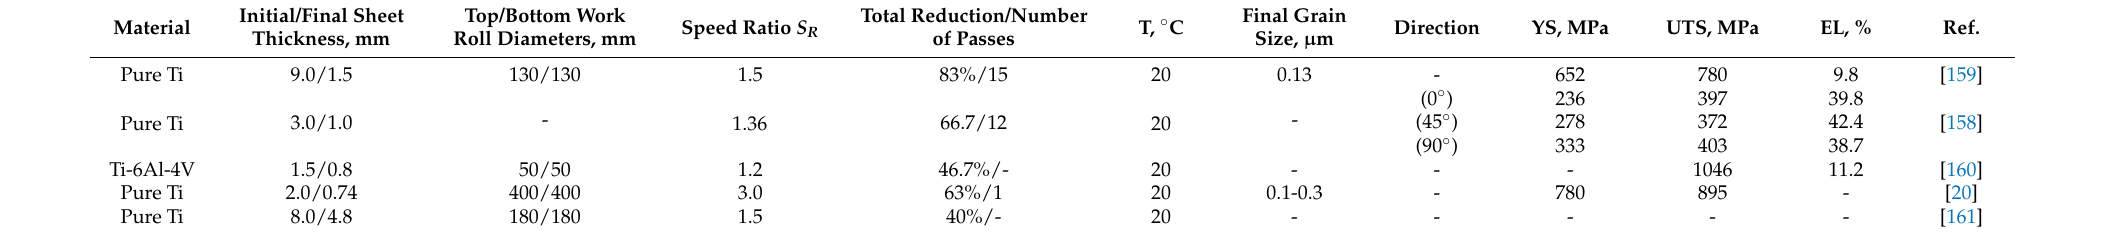
Table 10. Experimental data related to asymmetric cold rolling of Ti alloys.